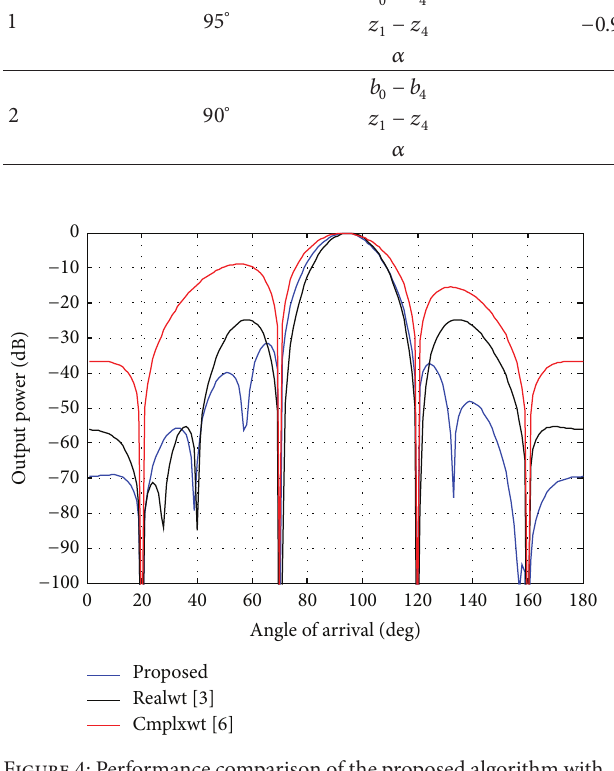
Figure 5: Performance comparison of proposed algorithm with INS bydecouplingrealweights[3],whensecondnullchangesitsposition from 70 ∘ to 75 ∘